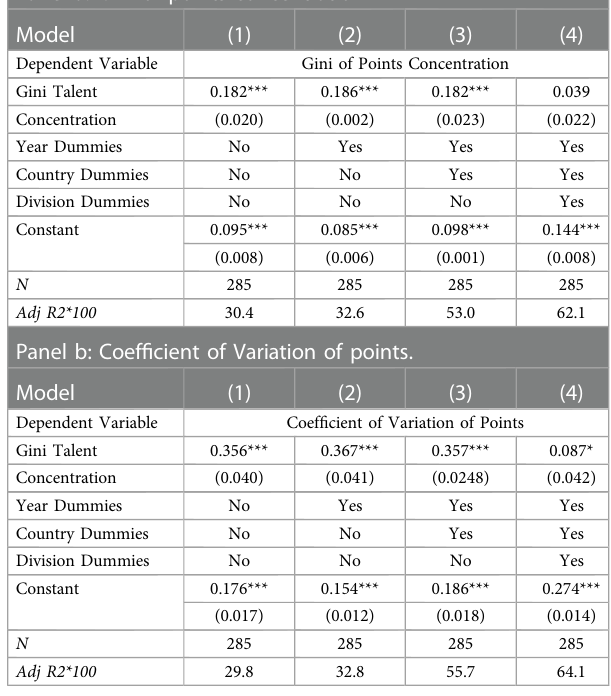
TABLE 4 Estimation